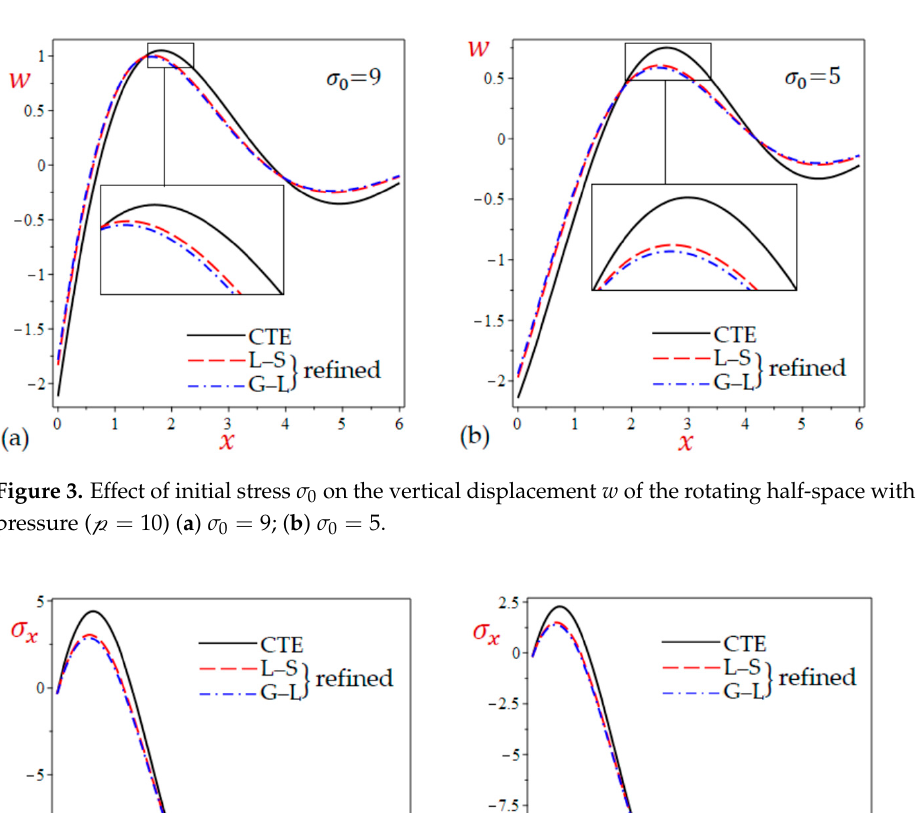
Figure 2. Effect of initial stress 𝜎 (cid:2868) on the horizontal displacement 𝑢 of the rotating half-space with initial pressure ( 𝓅 = 10 ) ( a ) 𝜎 (cid:2868) = 9 ; ( b ) 𝜎 (cid:2868) = 5 .